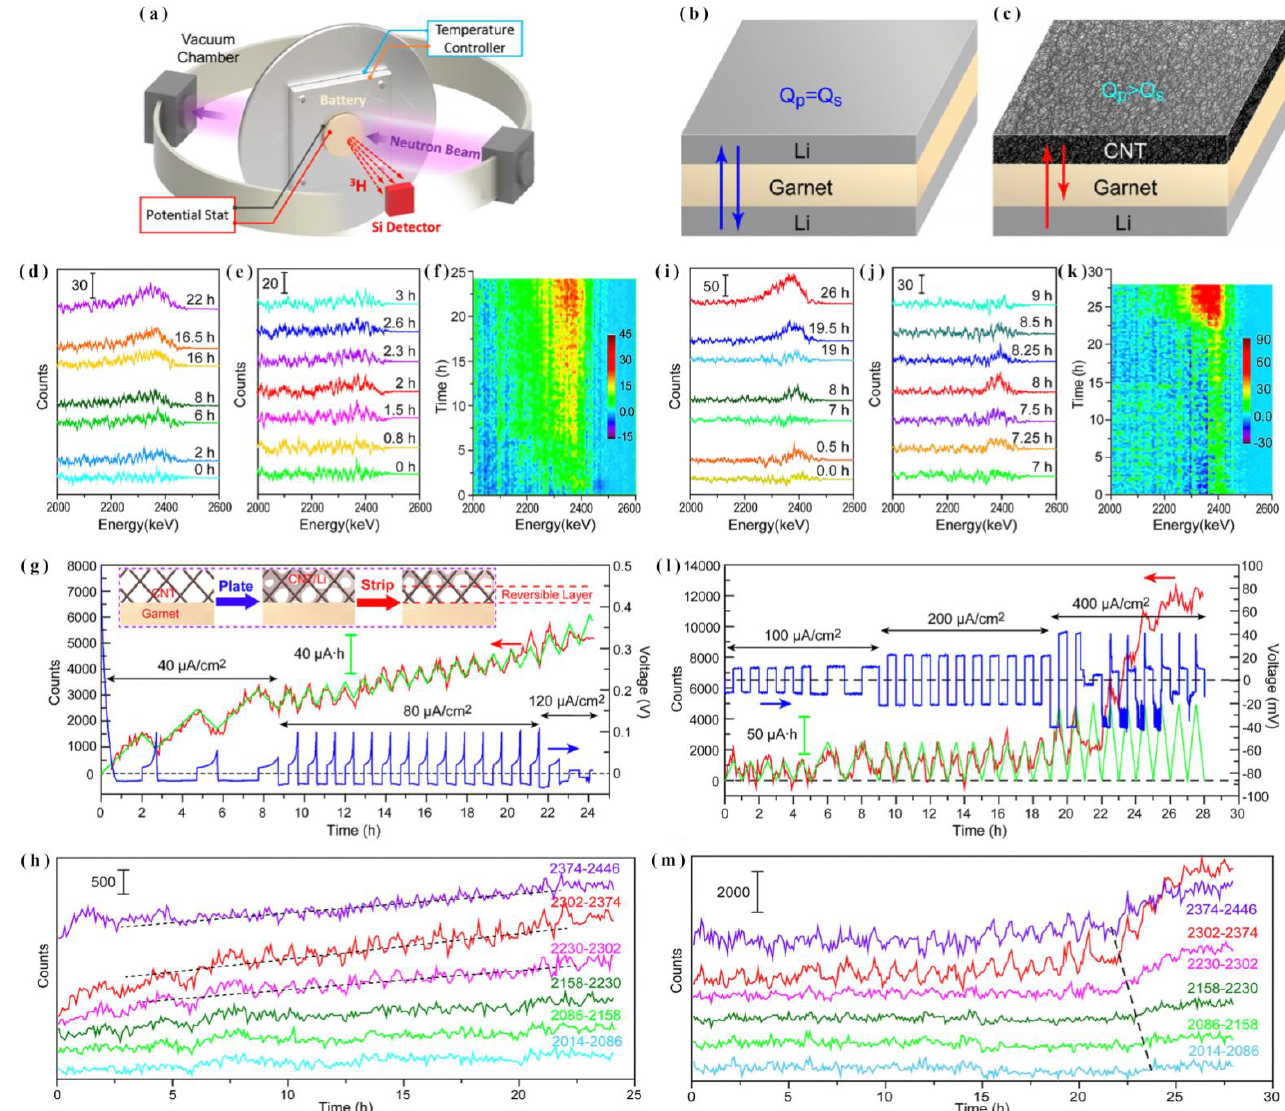
Figure 10. ( a ) The set-up for the NDP measurement , schematic of Li plating-stripping in a ( b ) Li/garnet/Li symmetric cell and ( c ) Li/garnet/CNT asymmetric cell, ( d – h ) in situ NDP measurement of a Li/garnet/CNT asymmetric cell while cycling, ( i – m ) in situ NDP measurement of a Li/garnet/Li symmetric cell during Li plating-stripping (adapted with permission from Ref. [40]. 2017 American Chemical Society).